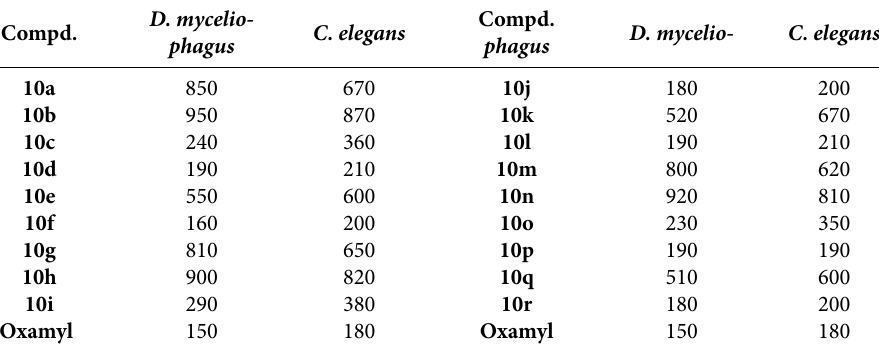
(ppm) of compounds 10a – r 50